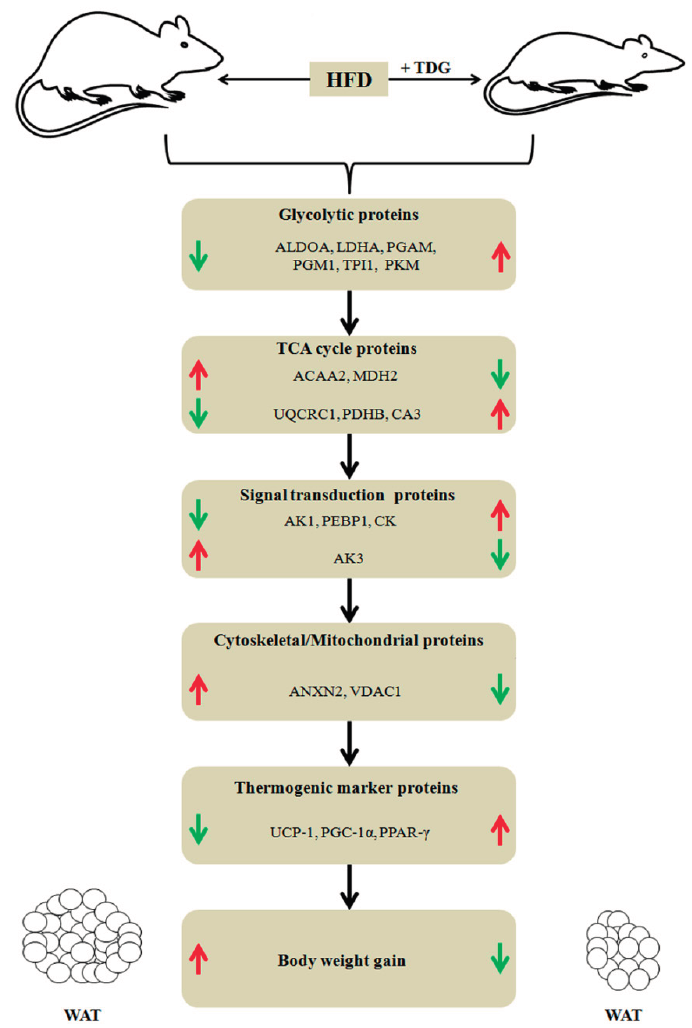
Figure 8. Brief summary of differentially regulated proteins, and phenotypic differences between high fat diet-control and TDG-treated rats: ( ↑ ) indicates up-regulation and ( ↓ ) indicates down-regulation of proteins. For full names of proteins, refer to Table 1 and abbreviation